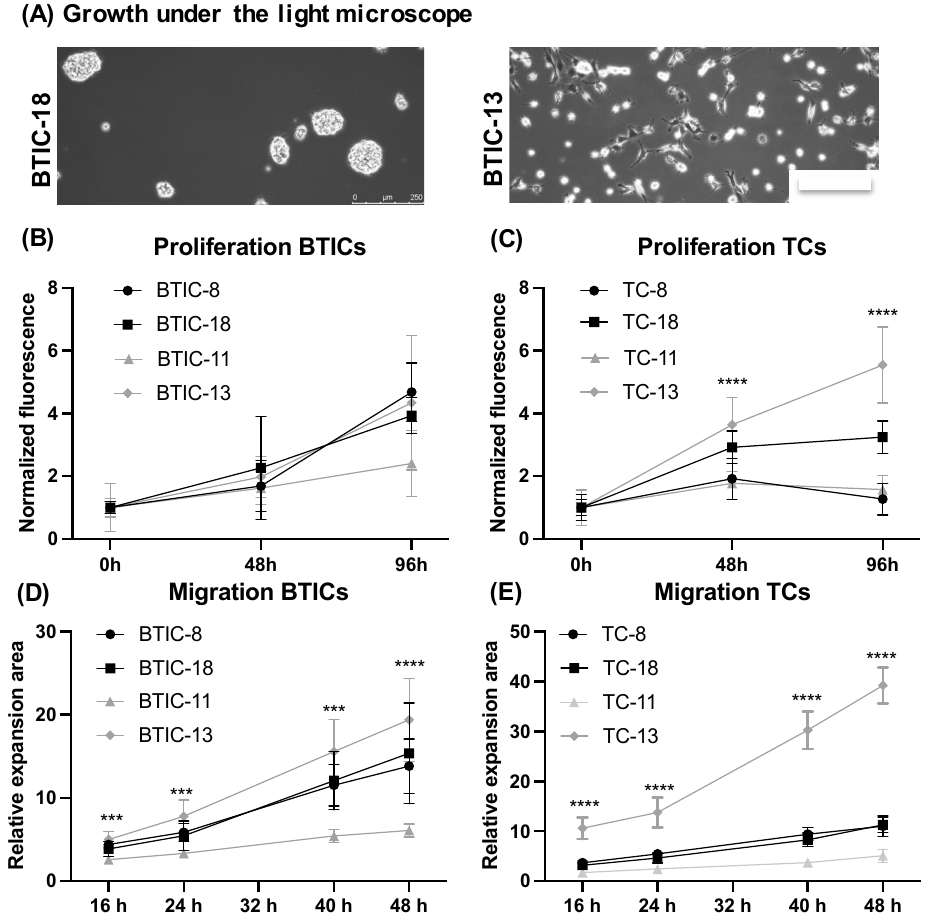
Figure 1. Characteristics of proneural and mesenchymal BTICs and TCs. ( A ) Proneural BTIC as exemplarily shown for BTIC-18, grew in spheres or semi-adherent, whereas mesenchymal BTICs, as exemplarily depicted for BTIC-13, showed adherent growth under the light microscope. ( B ) Proliferation assays were performed using the CyQuant Direct Cell Proliferation Assay and normalized to the 0 h value. Proliferation of proneural BTIC-8 and -18 and mesenchymal BTIC-11 and -13 varied across subtypes, which could also be observed for the corresponding differentiated TCs ( C ). Migration of BTICs ( D ) and TCs ( E ) in vitro was assessed using spheroid migration assays and normalized to the 0 h value. Again, migratory capacities varied across subtypes and differentiation states. All assays were performed in triplicate. Asterisks indicate *** p < 0.001, and **** p < 0.0001. The effects of metformin on proliferation were explored using the CyQuant Direct Cell Proliferation Assay 48 and 96 h after treatment with various concentrations of metformin. Treatment with metformin led to a dose- and time-dependent inhibition of proliferation among the four investigated BTICs and four TCs (Figures 2A and S3). After 96 h of high- dose metformin treatment, the fluorescence signal implicating cell number was even lower than at 0 h, which indicates cell death induction by metformin as described